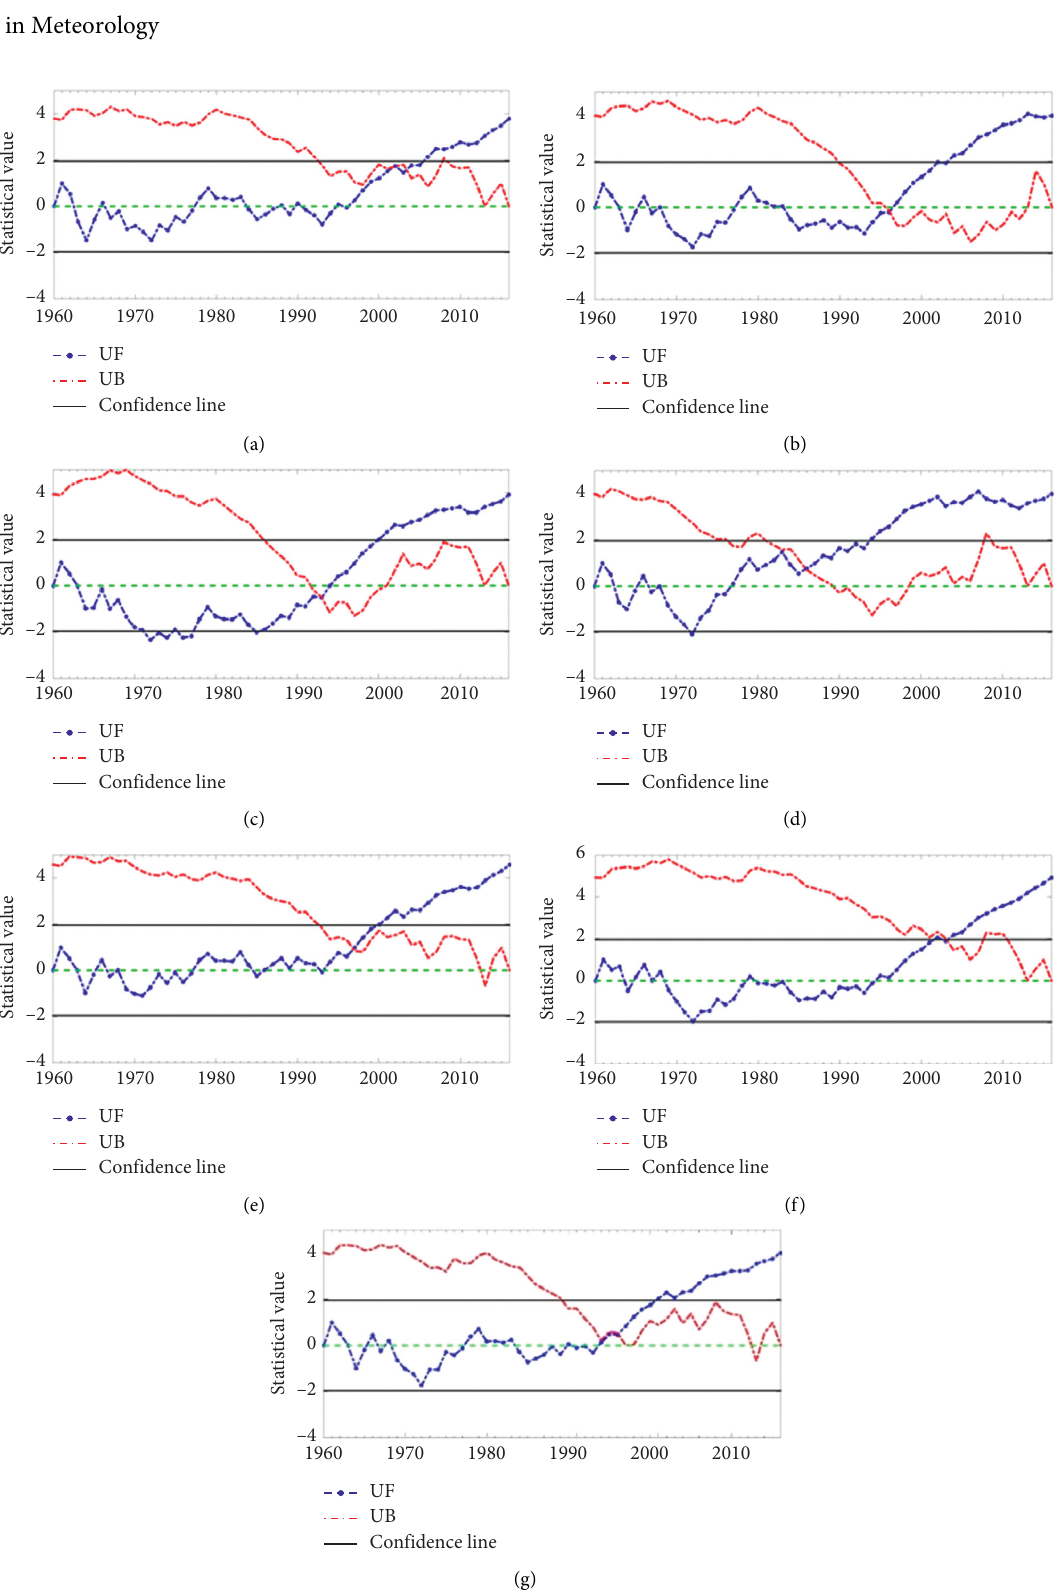
Figure 2: The trends of mean annual temperature through stations. (a) Xiangcheng station. (b) Zhumadian station. (c) Gushi station. (d) Fuyang station. (e) Xinyang station. (f) Xichong station. (g) Average